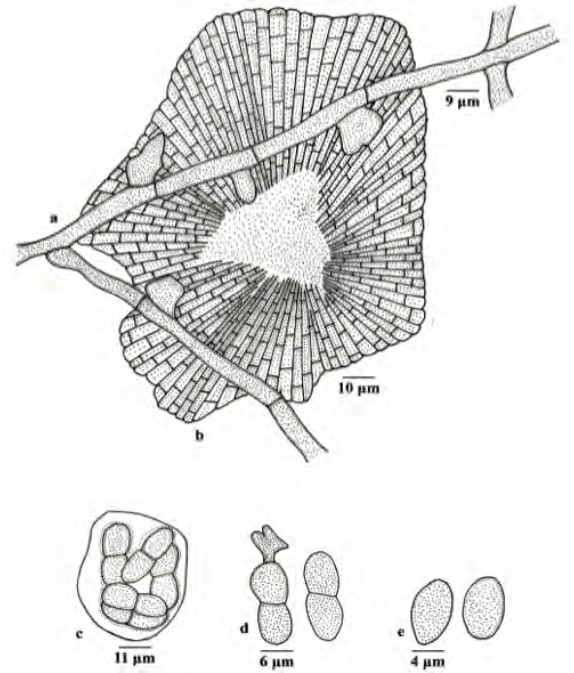
Figure 163. Asterina pusilla a - Appressorium; b - Thyriothecium; c - Ascus; d - Ascospores; e - Pycnothyriospores